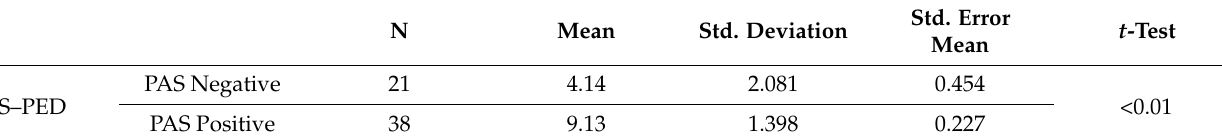
Table 6. Differences between PS–PED mean score and PAS.